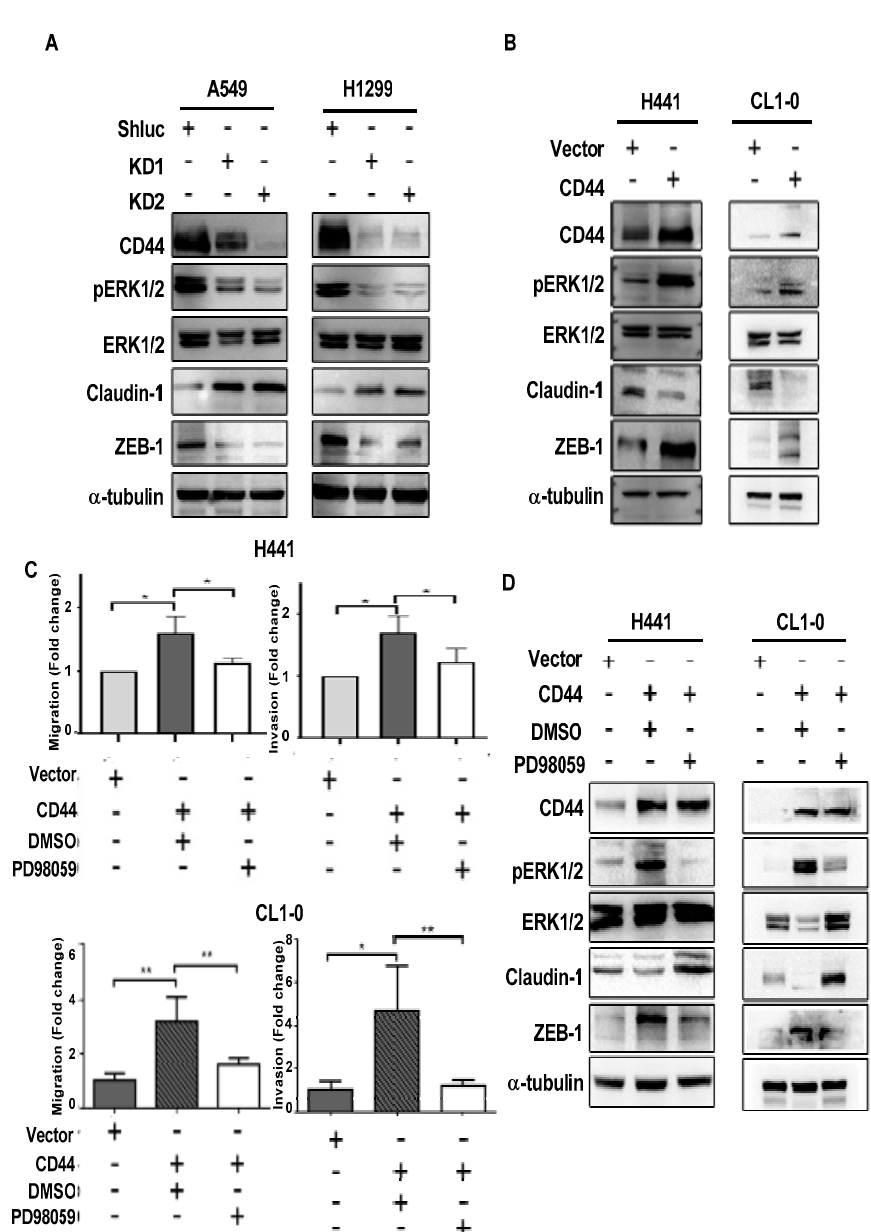
Figure 4. CD44 promoted migration and invasion abilities of lung cancer cells through ERK–ZEB1 signaling. ( a ) Western blot showing the expression pattern of p-ERK, ERK, Claudin-1, and ZEB1 in CD44-knockdowned A549 and H1299 cells. ( b ) Western blot showing the expression pattern of p-ERK, ERK, Claudin-1, and ZEB1 in CD44-overexpressing H441 and CL1-0 cells. ( c ) Effect of ERK inhibitor (PD98059, 25 uM) treatment for 48 h on migration and invasion abilities of CD44- overexpressing H441 and CL1-0 cells. ( d ) Western blot showing the expression pattern of p-ERK, ERK, Claudin-1, and ZEB1 in CD44-overexpressing H441 and CL1-0 cells after ERK inhibitor PD98059 (25 uM for 48 h) treatment. * p < 0.05, ** p < 0.01.